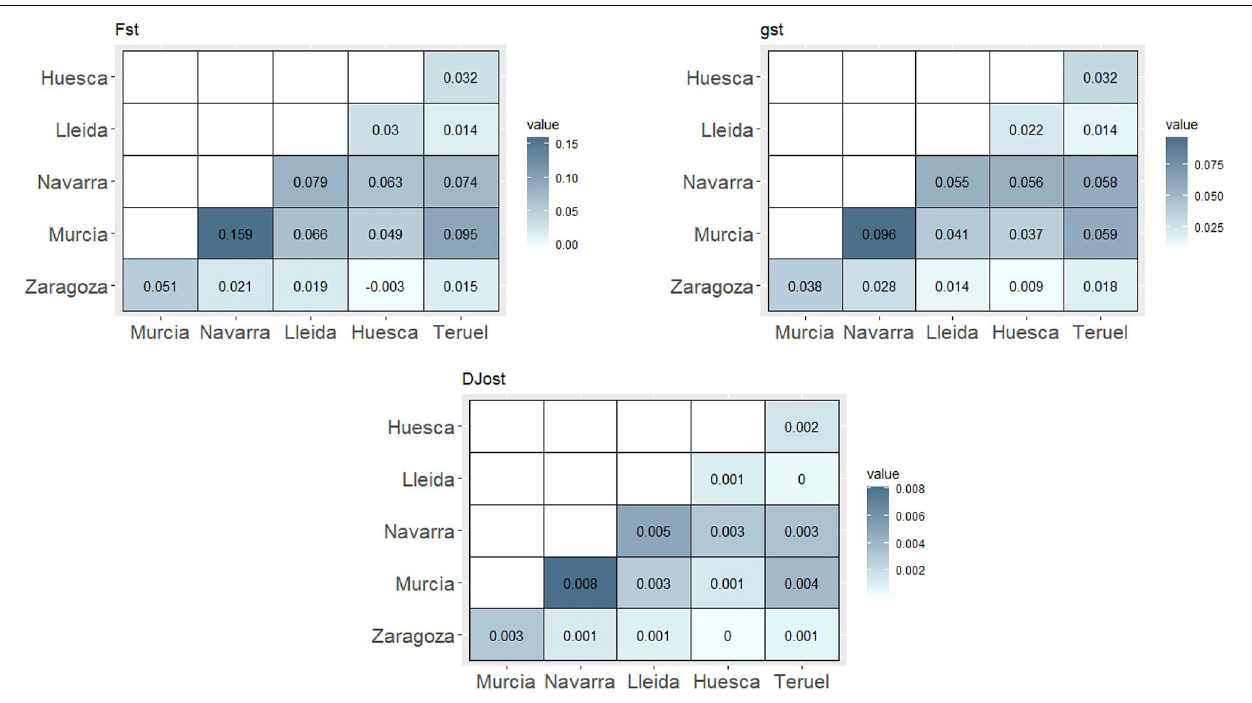
FIGURE 1 | Genetic differentiation pairwise analysis among Spanish regions.